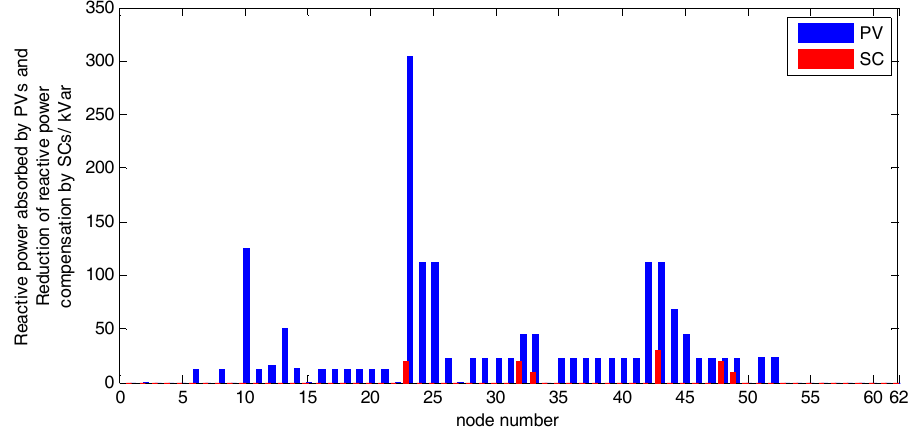
Figure 17. Reactive power absorbed by the PVs and reduction of the reactive power compensation by SCs/kVar based on centralized control.